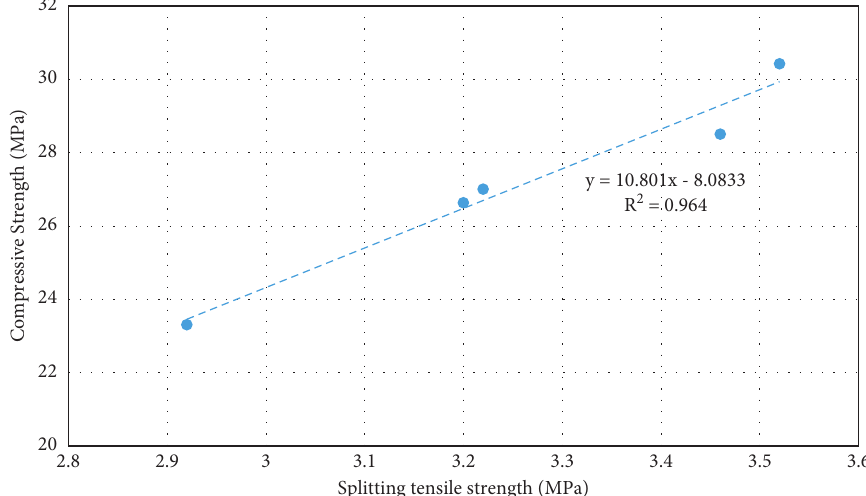
Figure 9: Correlations between compressive strength and splitting tensile strength at 28 days.